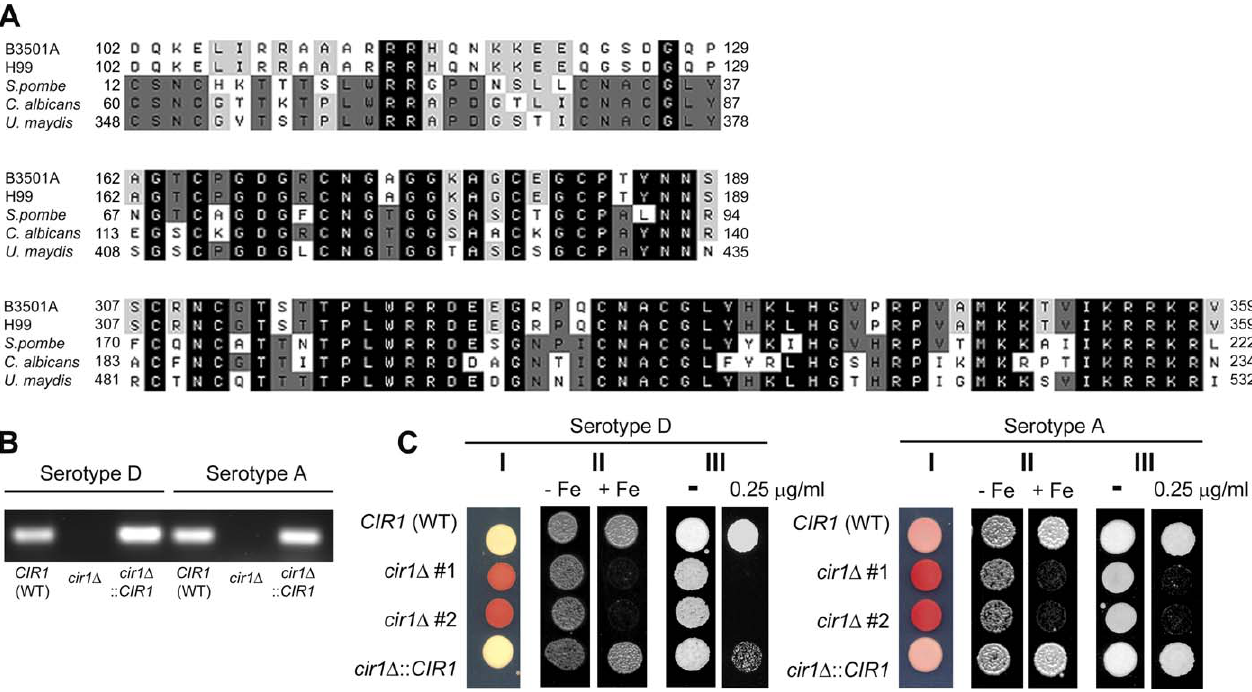
Figure 1. Conserved Regions of Cir1 and Iron-Related Phenotypes of cir1 Mutants (A) Amino acid alignment of Cir1 with other fungal GATA-type iron regulators: Sc. pombe Fep1 (AAM29187), Ca. albicans Sfu1 (AAM77345) and U. maydis Urbs1 (AAB05617). Only the segments of the alignments containing the highly conserved N- or C-terminal zinc finger motifs (top and bottom alignments, respectively) and the cyteine-rich region are shown (middle alignment). Cir1 only has the C-terminal zinc finger motif. (B) RT-PCR results showing that CIR1 transcripts are not produced from the cir1 mutants, indicating complete disruption of the gene. WT. wild type. (C) Panel I, the cir1 mutants display increased cell surface reductase activity as indicated by the red colony color in the presence of TTC; panel II, The cir1 mutants are highly sensitive to elevated iron levels ( þ Fe, 0.75 mM ferrozine þ 200 l M FeEDTA), but not to iron restriction ( (cid:2) Fe, 0.75 mM ferrozine); and panel III, the cir1 mutants are more sensitive to phleomycin (0.25 l g/ml). Two independent mutants (#1 and #2) displayed the same phenotypes. DOI: 10.1371/journal.pbio.0040410.g001